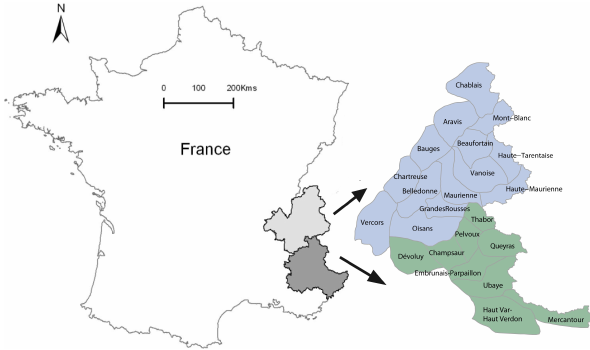
Fig. 1. Area studied. The French Alps are divided into 23 mas- sifs. The Northern French Alps and Southern French Alps are rep- resented in blue and green,